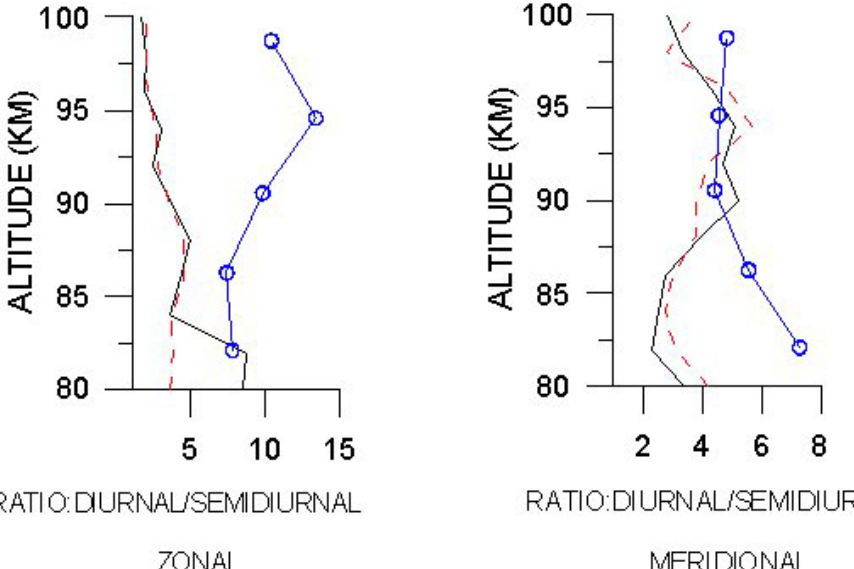
Fig. 8. Comparison between diurnal and semidiurnal tidal wind components for Cachoeira Paulista (23 ◦ S). Broken lines: 1999 to 2000; solid line: 2000 to 2001; line with points: GSWM (after Batista et al.,